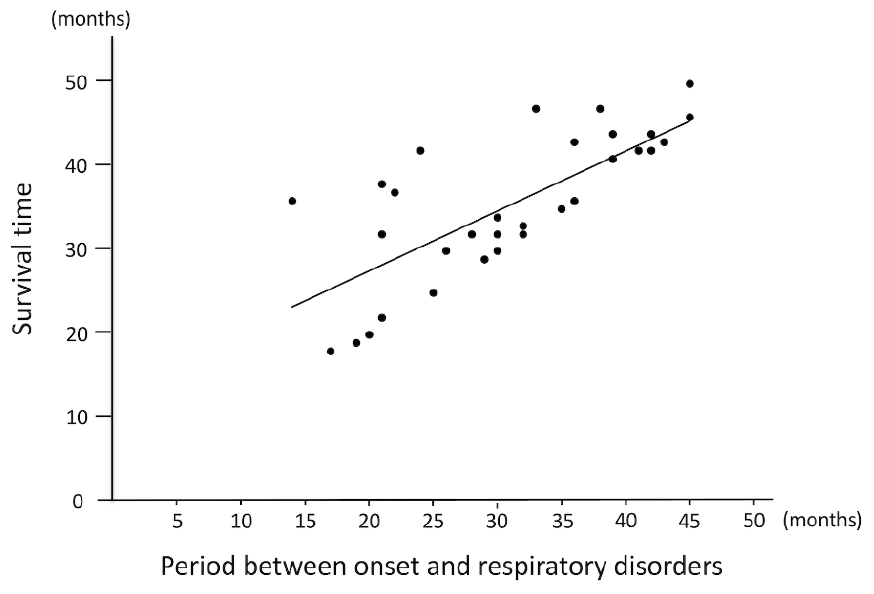
Figure 2. The relationship between the onset of dyspnea and survival time ( n =